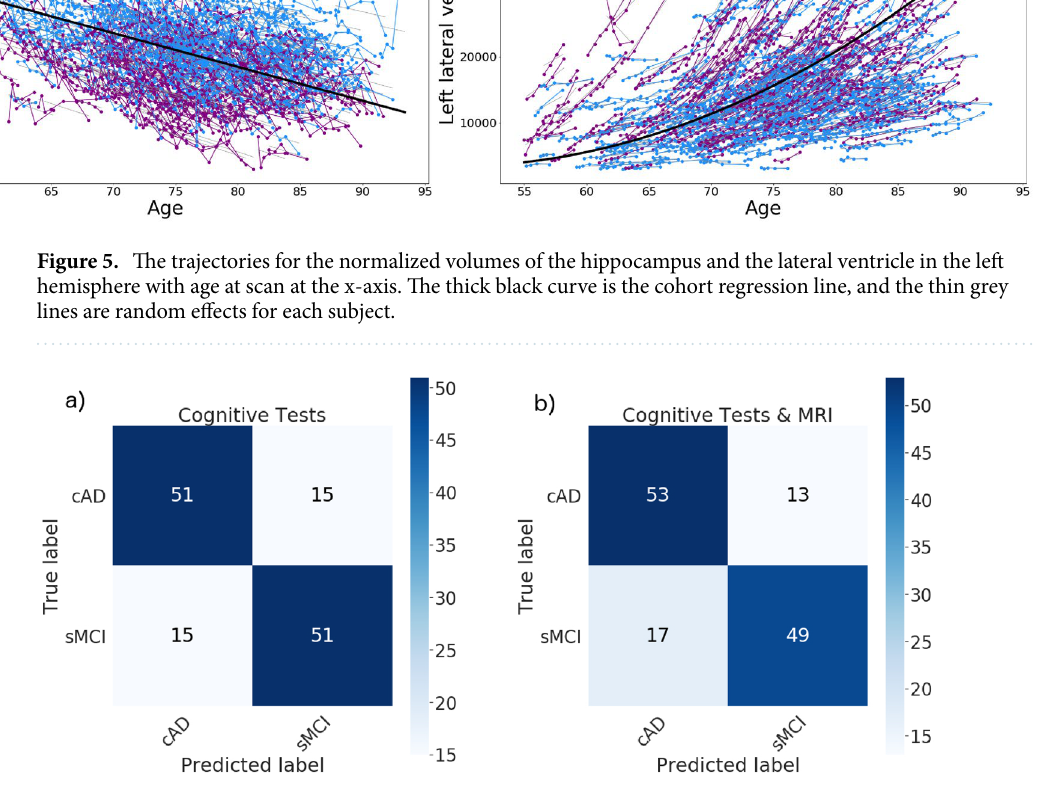
Figure 6. Confusion matrices for classification of sMCI vs. cAD from the cognitive features ( a ) and the combination of MRI and cognitive features ( b